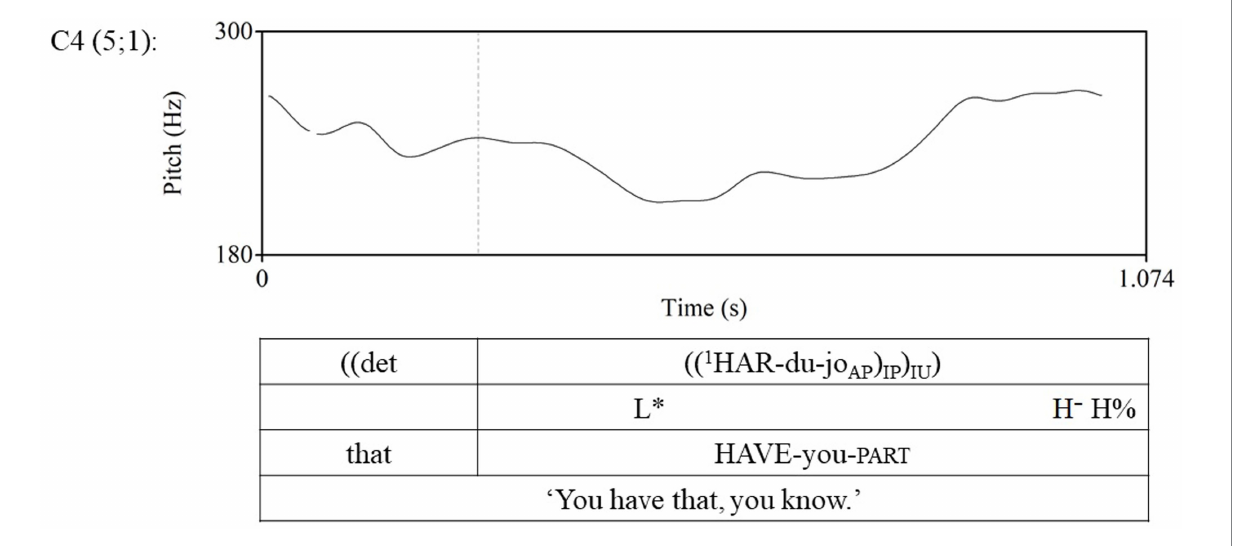
FIGURE 8 F0-contour of ‘non-PF utterance’ with similar pragmatic effect as a PF utterance.